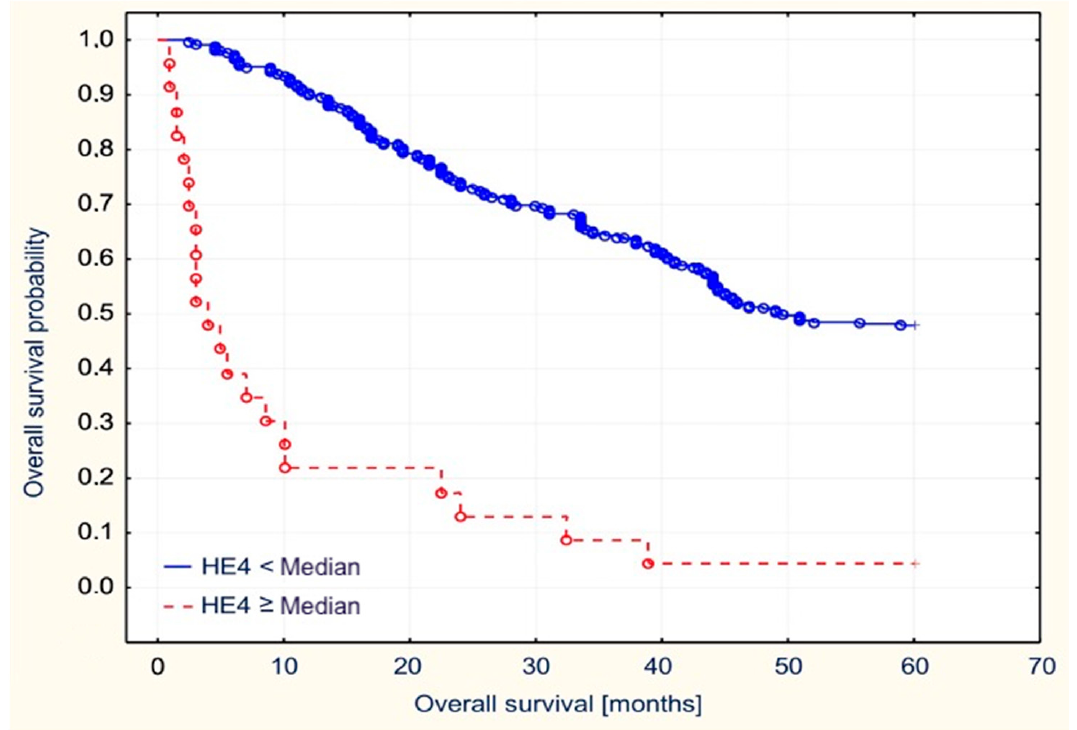
Figure 7. Overall survival stratified by the cut off HE4 value in the examined patients with endometrial cancer.